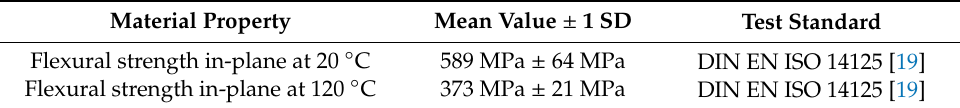
Table 1. Measured mechanical material properties of investigated carbon fiber SMC [18].